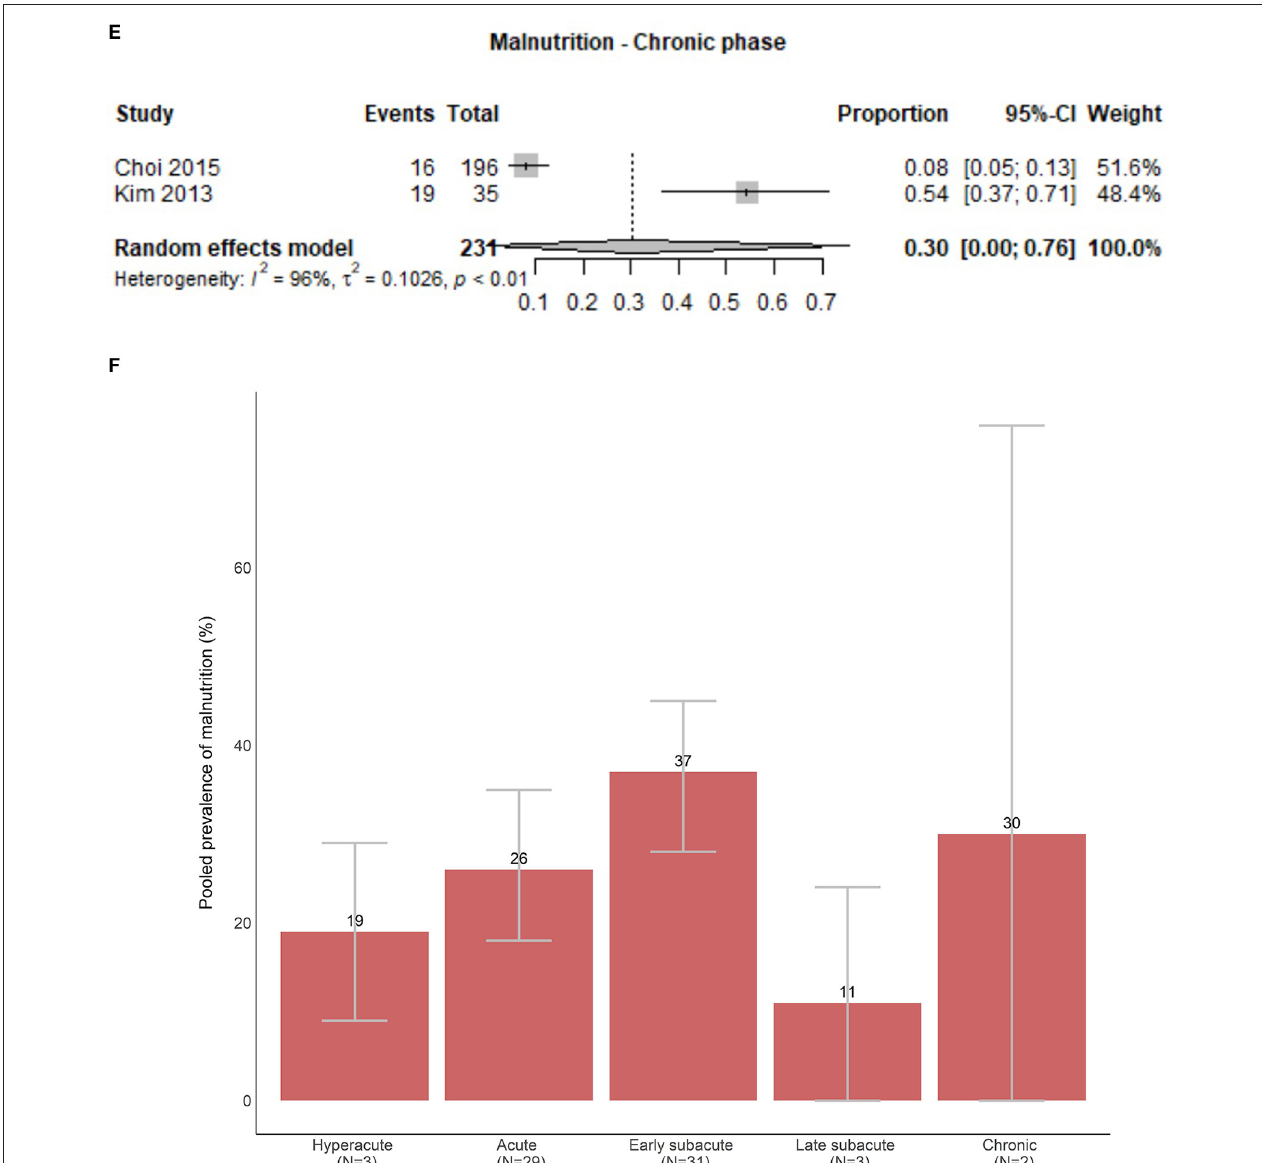
FIGURE 4 | (A) Pooled prevalence of malnutrition in the hyperacute phase. (B) Pooled prevalence of malnutrition in the acute phase. (C) Pooled prevalence of malnutrition in the early subacute phase. (D) Pooled prevalence of malnutrition in the late subacute phase. ( E ) Pooled prevalence of malnutrition in the chronic phase. (F) Pooled prevalence estimates of malnutrition per phase. Figure 7 . The risk of bias and relative risk for each individual study group is provided in the Supplemental Table 4